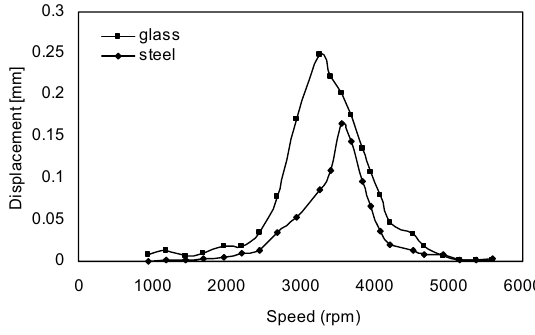
Fig. 8. Damper material effect on vibration amplitude (L/D =